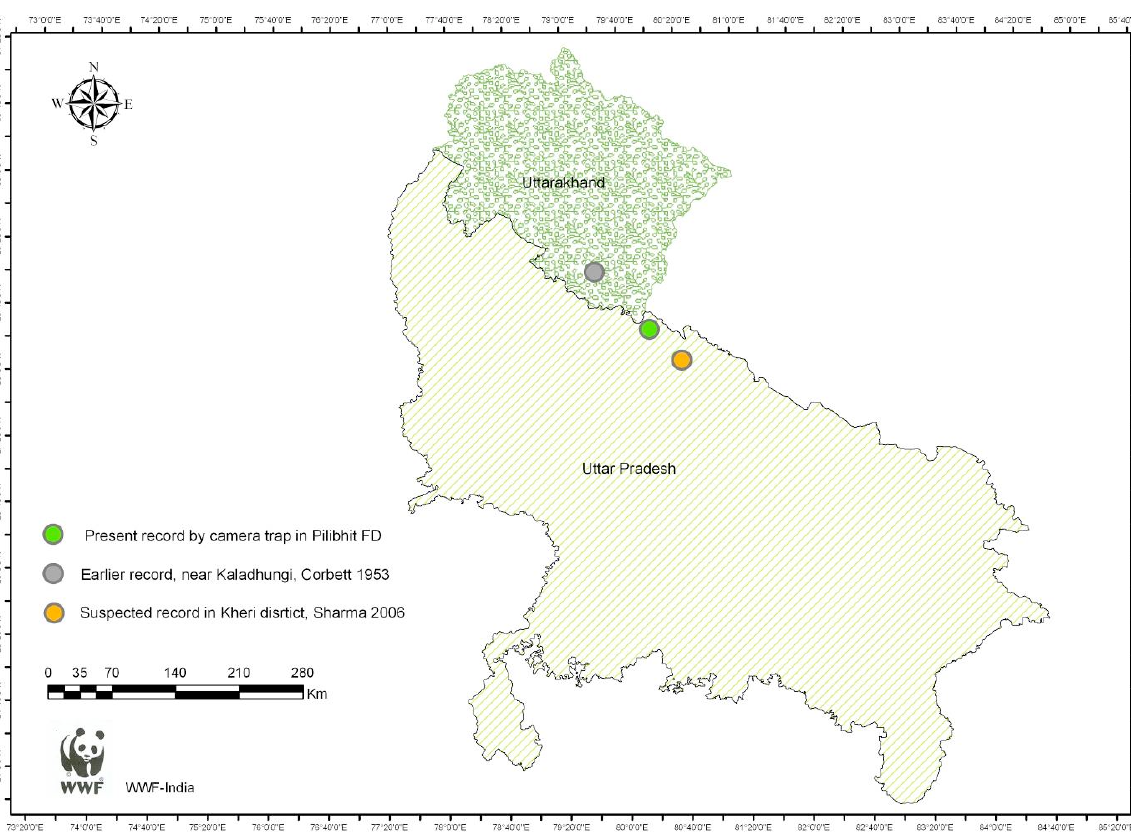
Figure 2. Records of Four-horned Antelope in Terai Arc Landscape of Uttar Pradesh: present record (green dot) in Pilibhit District, and suspected record in Kheri District (orange dot). Earlier record near Kaladhungi in Uttarakhand is shown as a grey dot. The record from Pilibhit makes the range of distribution continuous from Kheri to